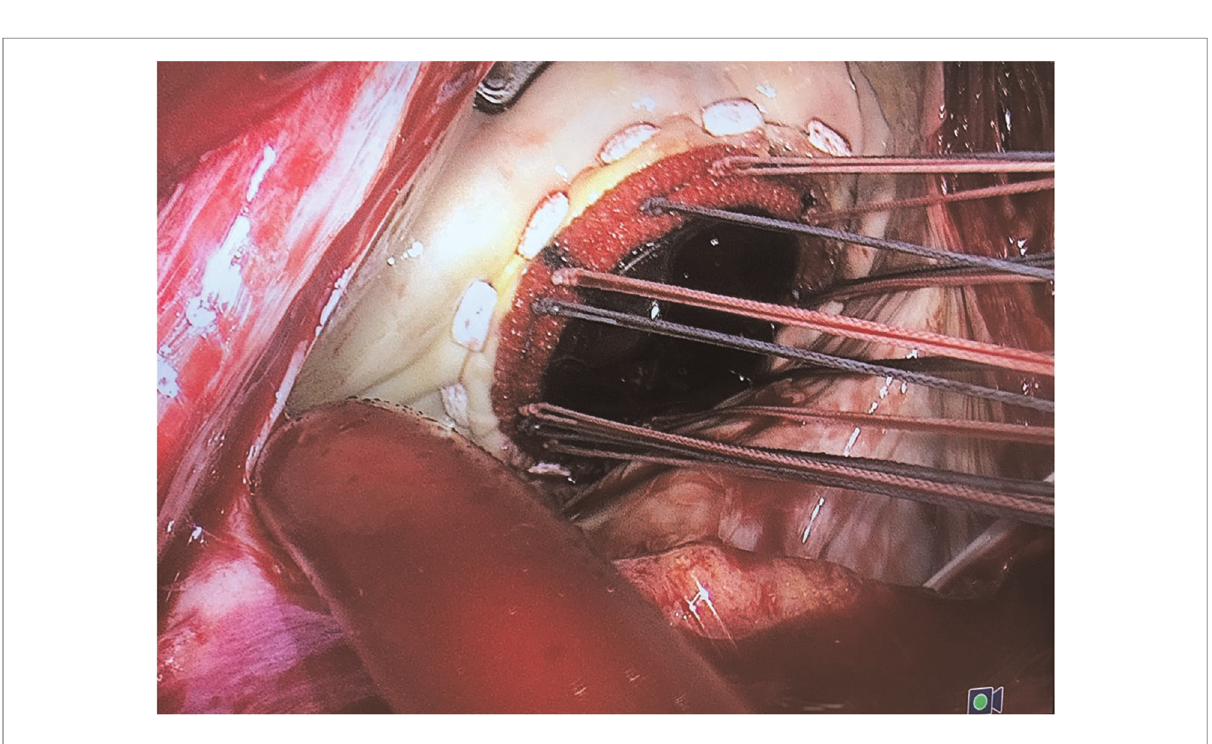
FIGURE 2 Surgical implantation of a mitral mechanical prosthesis using the novel side exiting pledgetted